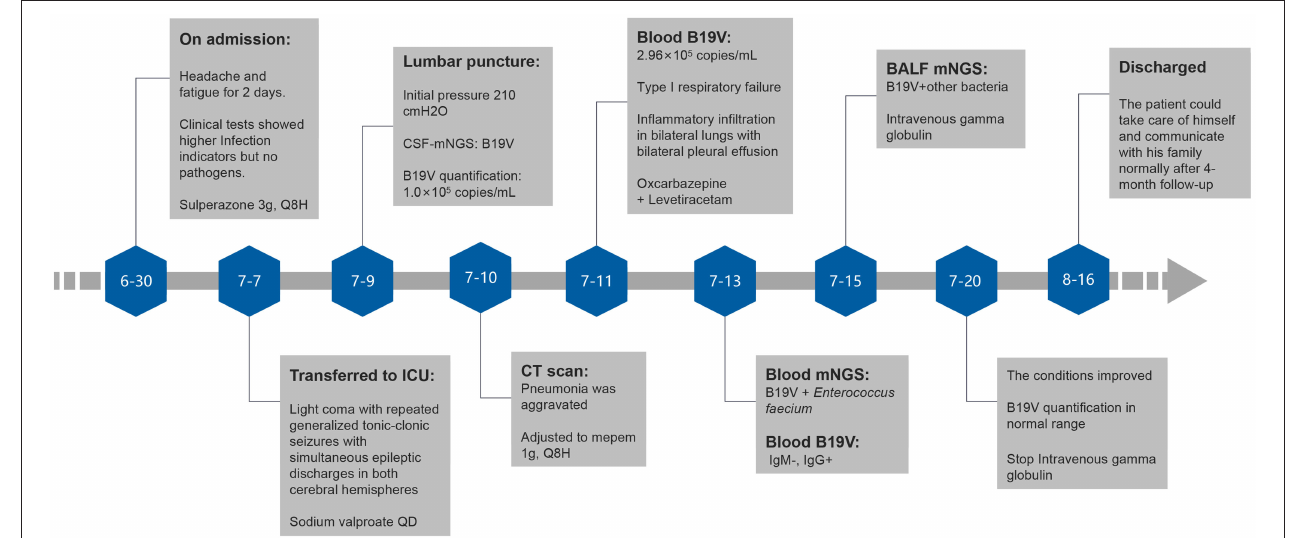
FIGURE 3 | The timeline of this